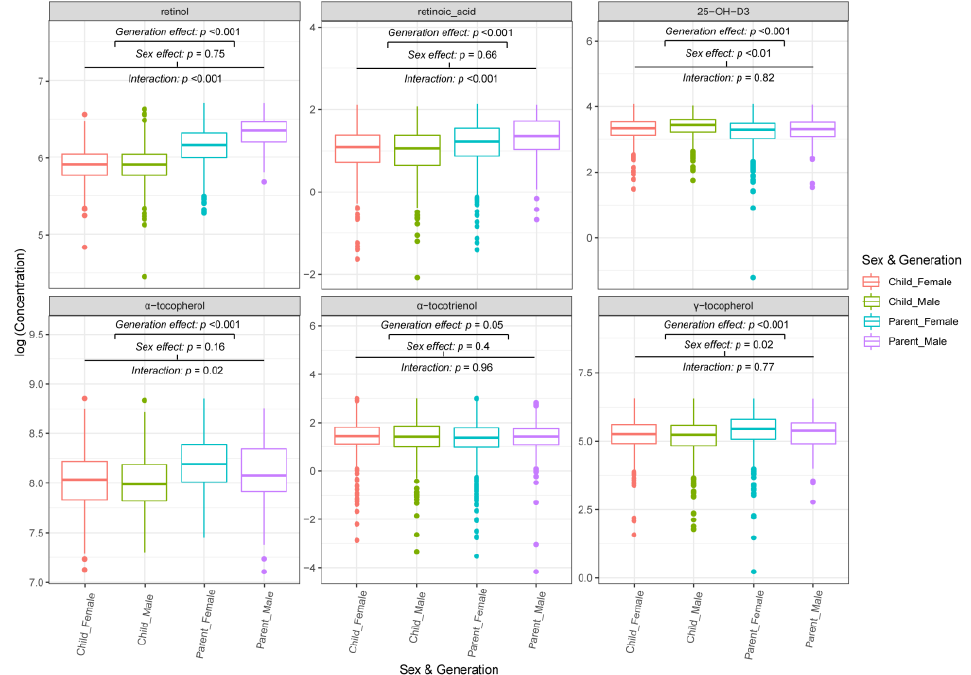
Figure 2. Box plots showing FSV concentrations by sex and generation. Outliers that were >2 standard deviations from the mean have been excluded from statistical analysis and the box plots. Mixed models were used to calculate p -values. The significance of the sex and interaction effect indicates whether the effect of sex differed between parents and children. A significant sex effect without significant interaction indicates that the sex effect is similar in the two generations. Where the interaction was significant, the sex effect was seen in adults only, without significant differences between male and female children.